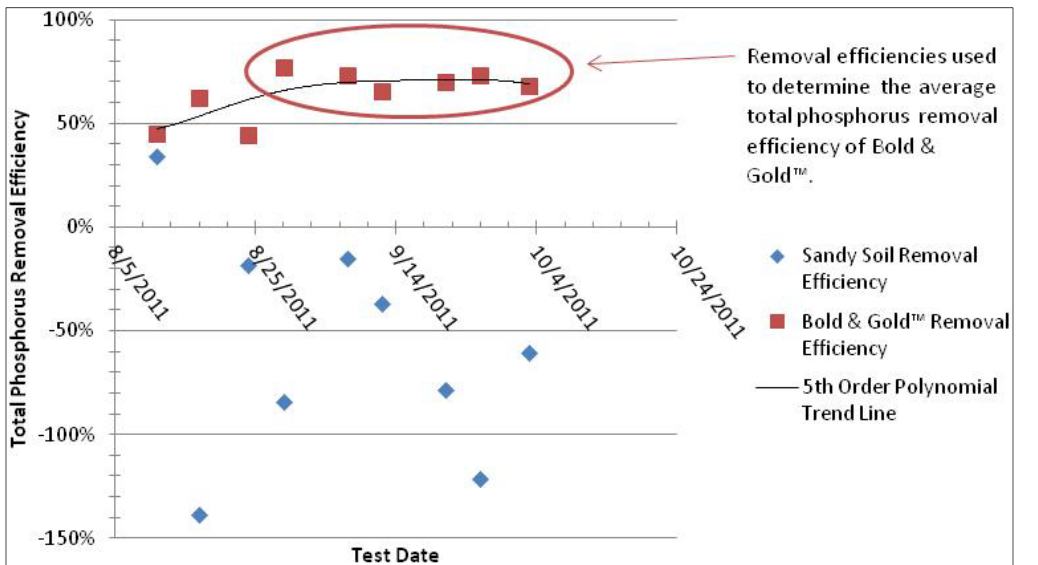
Figure 8. Total phosphorus removal efficiencies of field scale bio-filtration